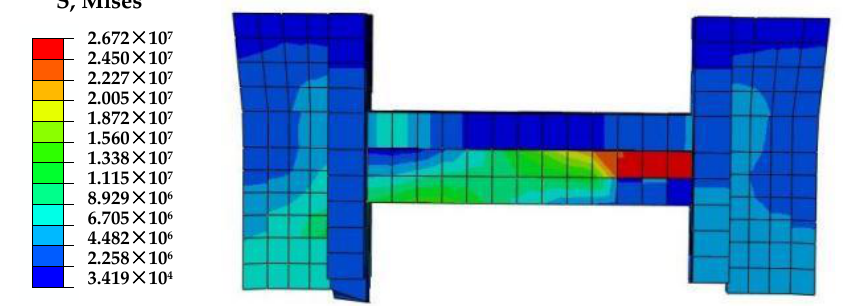
Figure 12. Stress distribution of composite coupling beam.